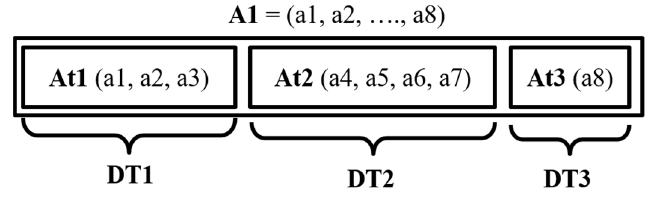
Figure 2. Data partitioning mechanism according to data type.